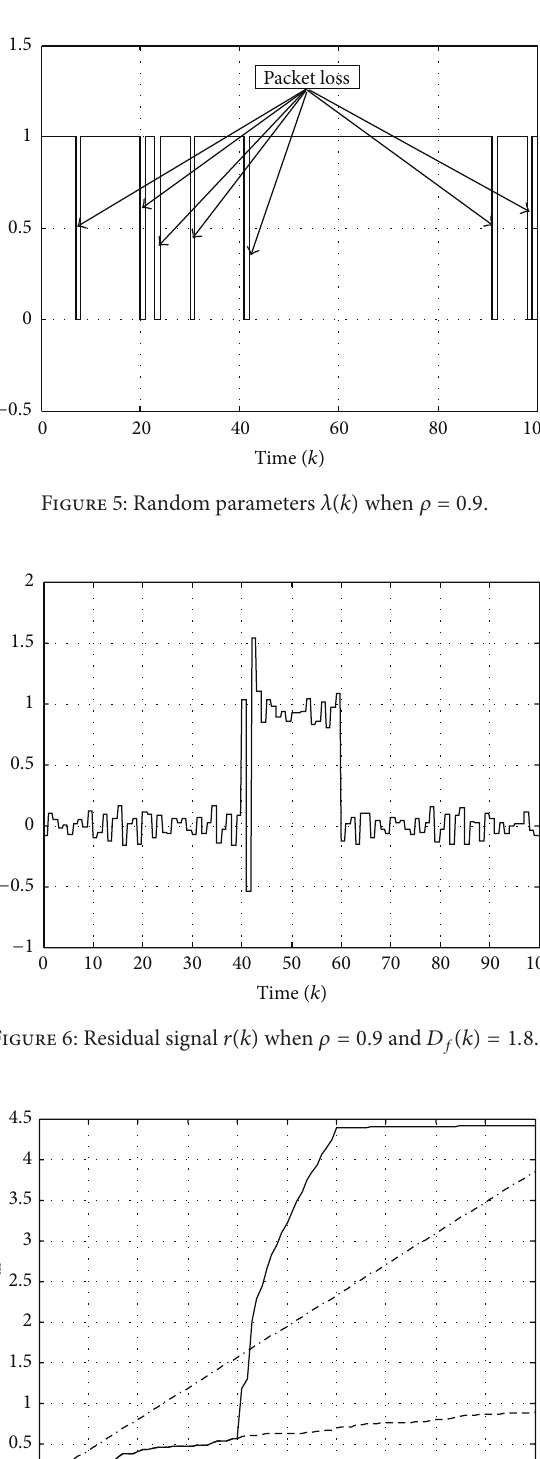
Figure 7: Residual evaluation function 𝐽(𝑟, 𝑘) and threshold 𝐽 when 𝜌 = 0.9 and 𝐷 𝑓 (𝑘) = 1.8